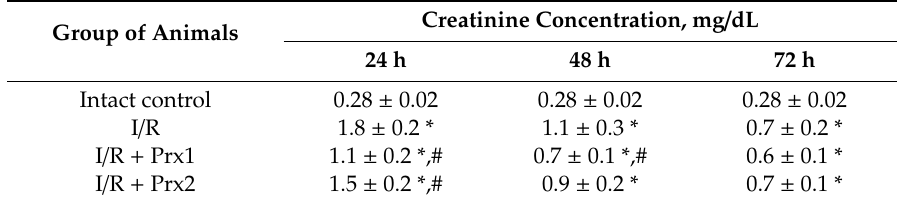
Table 5. Creatinine concentration in the blood of mice over three days after I / R injury of both kidneys. Group of Animals